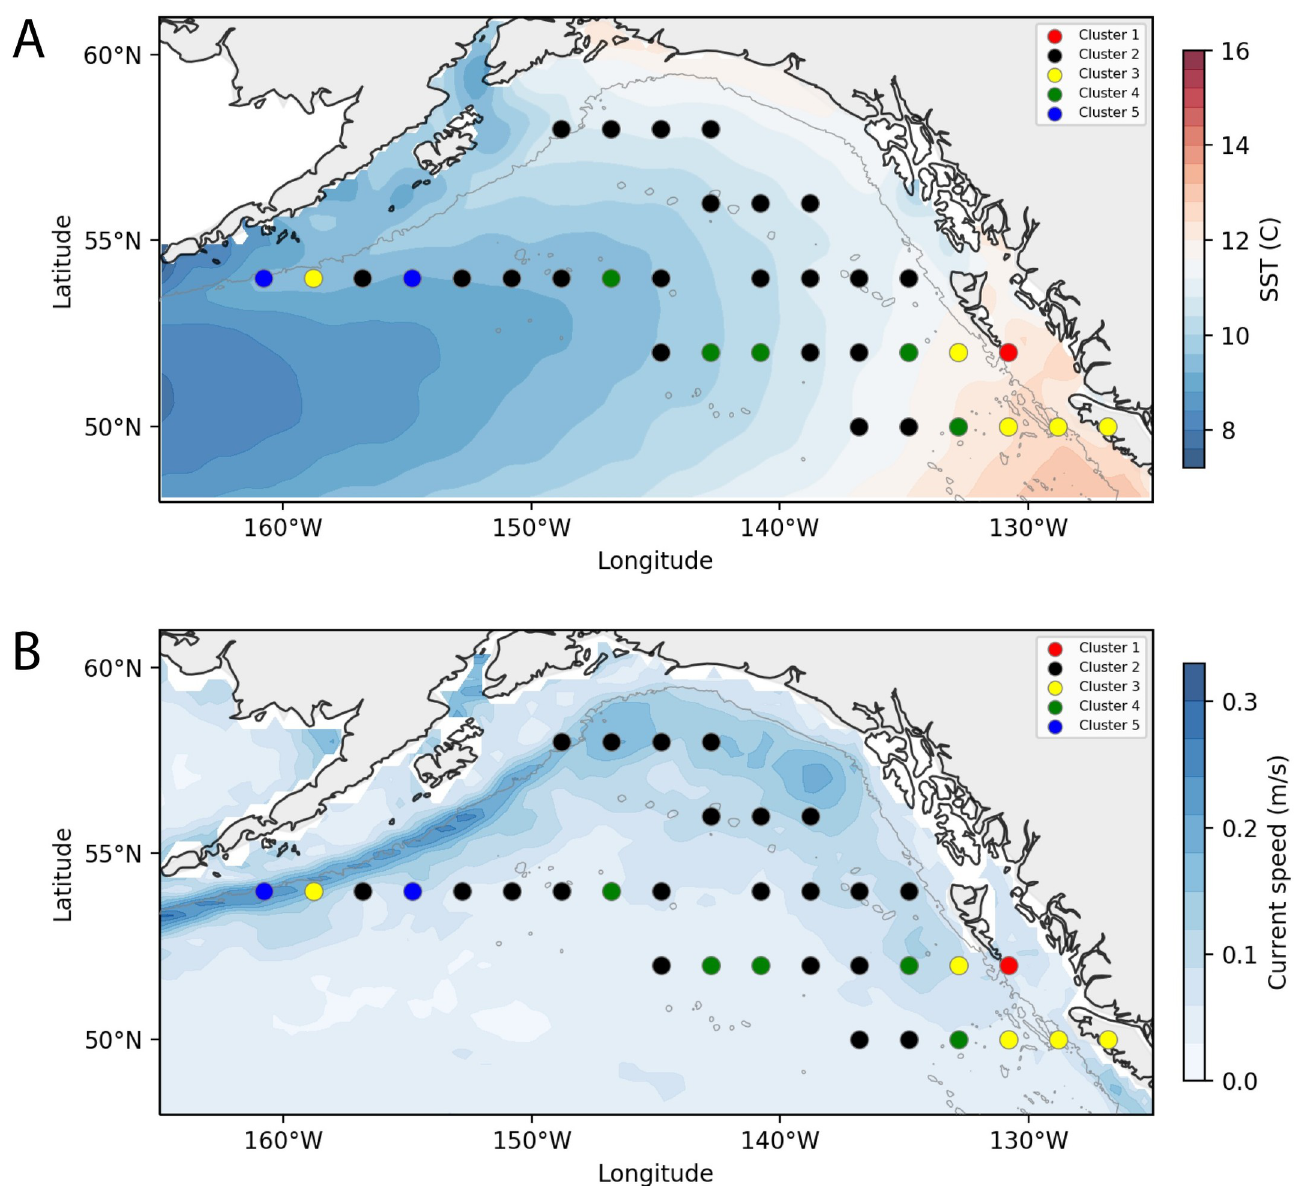
Fig 5. Climatology maps (May 16-August 15, 2004–2016). Spatial maps depicting (A) SST, (B) mean current speed. Dots indicate previously defined zooplankton community clusters (identified by color). Current speeds averaged in both meridional and zonal axes.